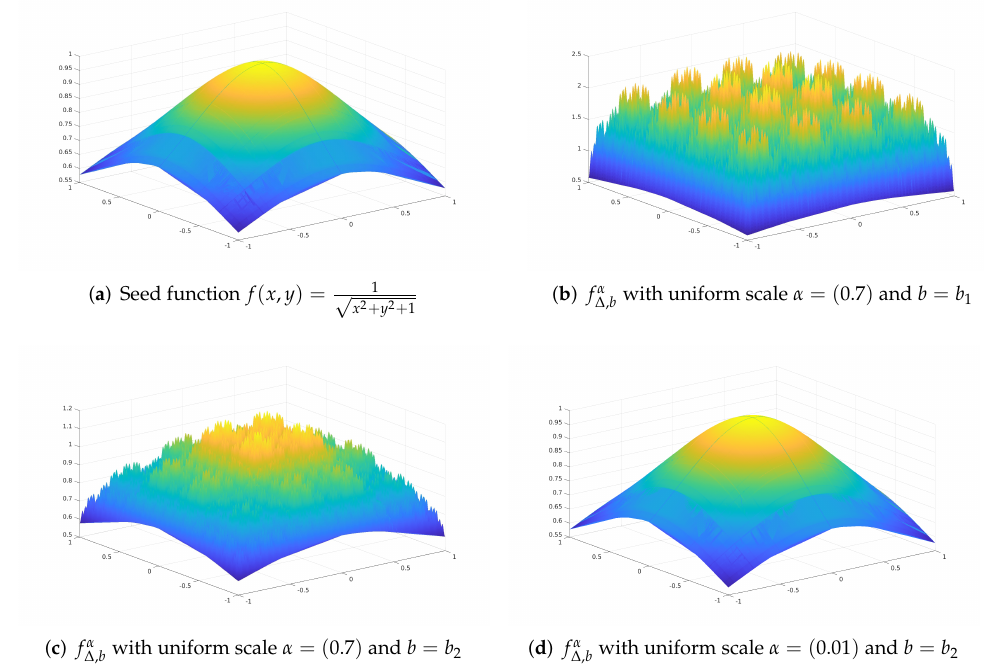
Figure 1. Fractal functions corresponding to the seed function f associated with different choices of base function and scale